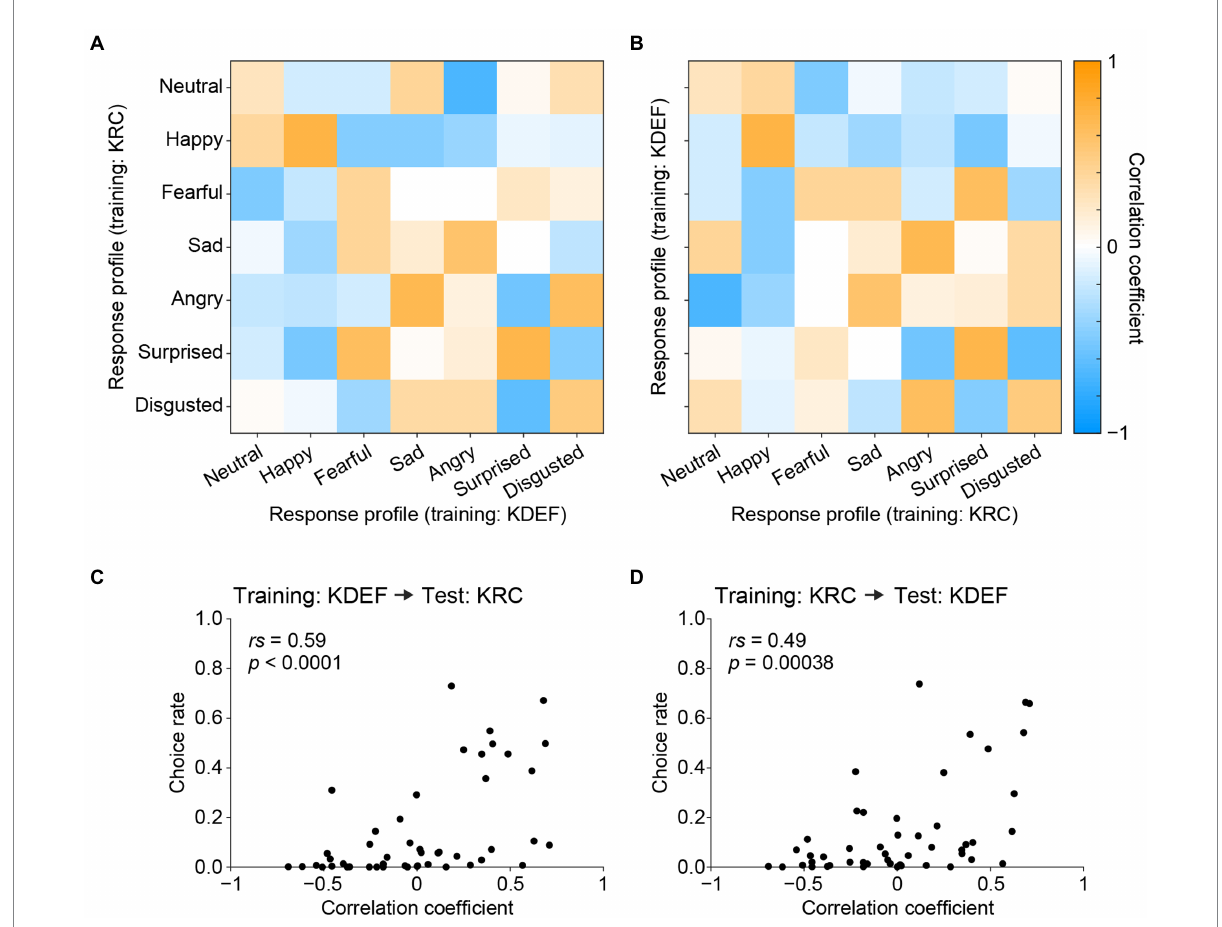
FIGURE 9 Correlation matrix of the response profiles of the KDEF-trained and KRC-trained CNNs and its relation to the confusion matrix in the database- swapped conditions. (A,B) Correlation matrix computed with the full profiles between the KDEF-trained and KRC-trained CNNs. Note that the horizontal axis and vertical axis are interchanged between (A) and (B) , while correlation values themselves are unchanged. (C,D) Correlation between the correlation matrix and confusion matrix in the database-swapped conditions. There are 49 (7 × 7) data points in the scatter plots, each data point representing the combination of two facial-expression